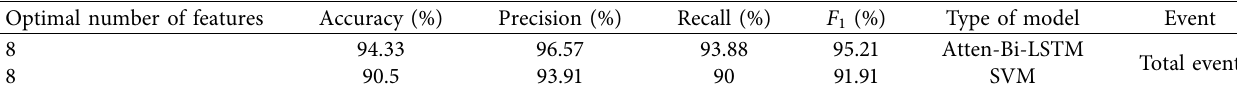
Table 10: Comparison of distracted driving behavior recognition results of different algorithms. Optimal number of